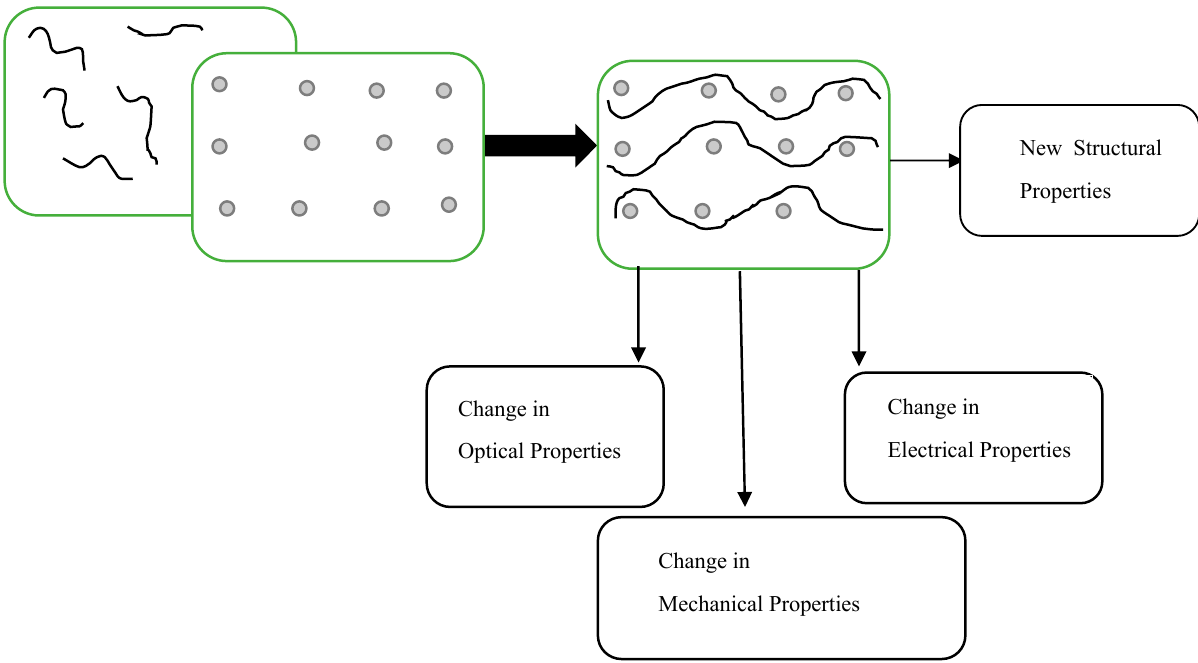
Figure 7. Illustration of the addition of nanoparticles into polymer matrices; it results in the alteration of optical, mechanical, and electrical properties in relation to the host polymer.